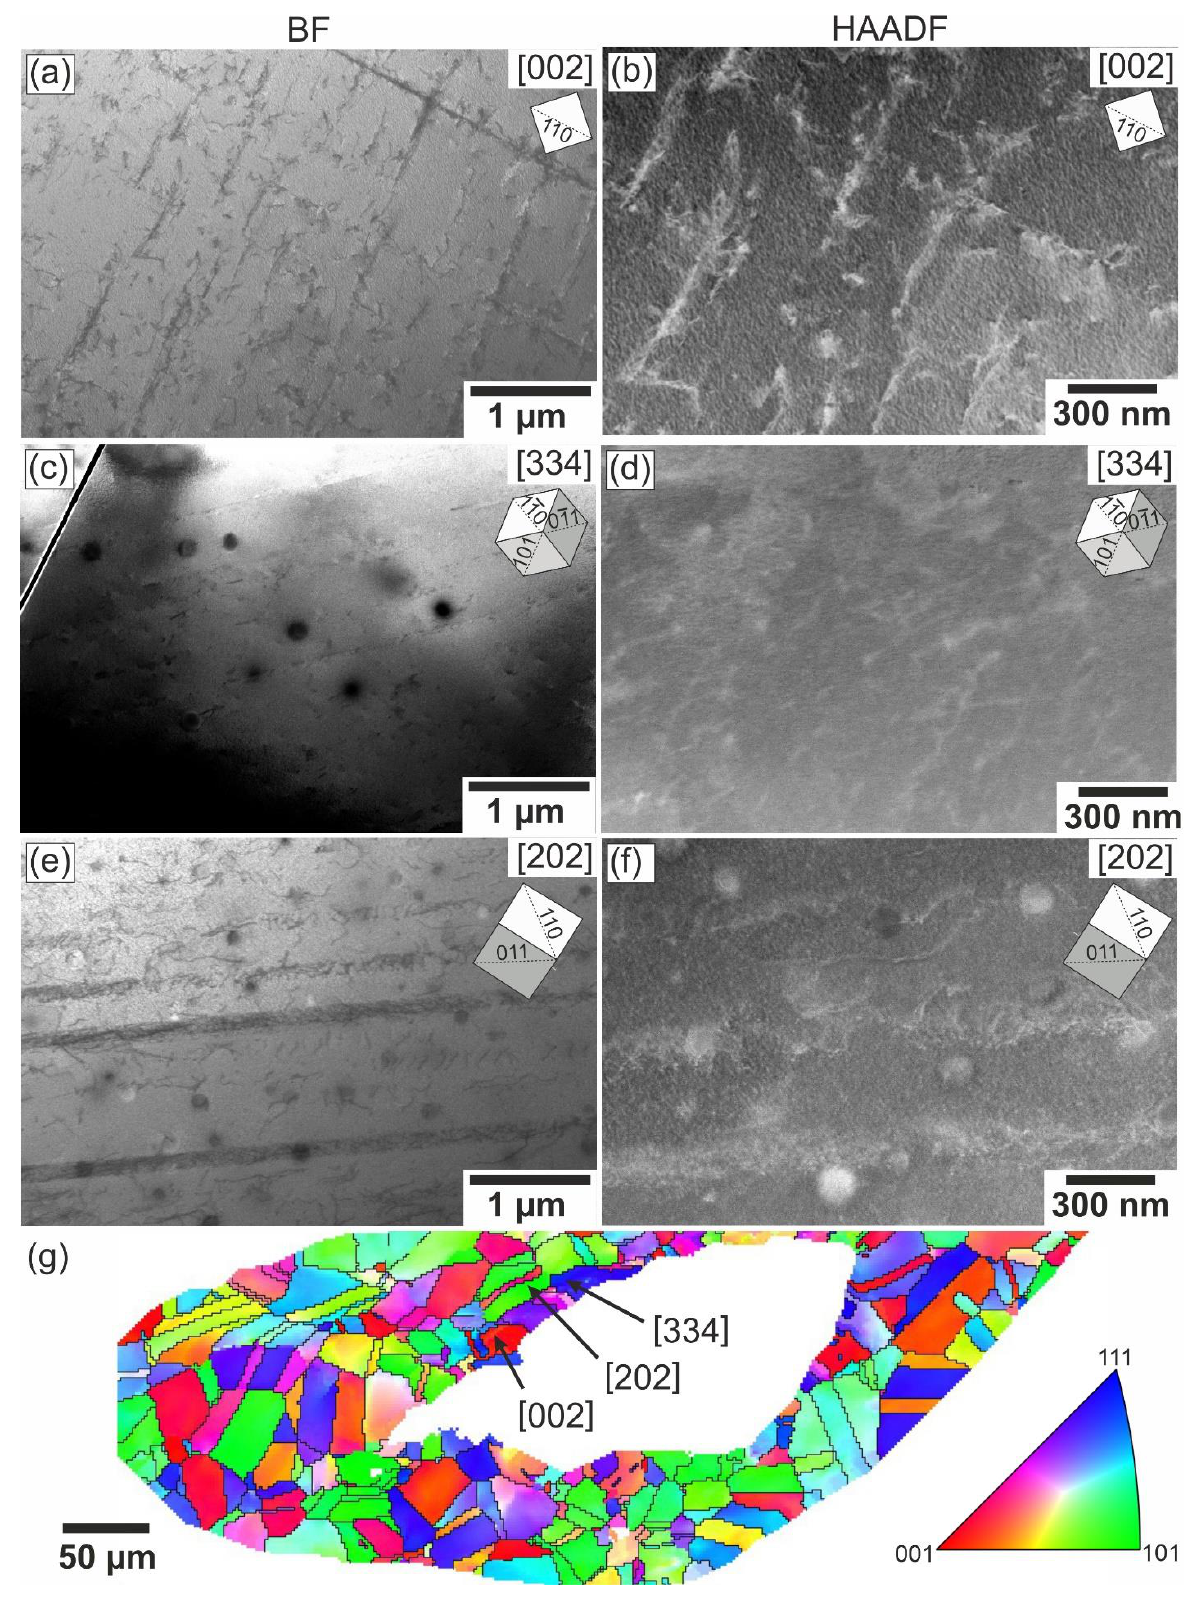
Figure 9. ( a , c , e ) BF and ( b , d , f ) HAADF STEM images of three grains with different orientations in the sample deformed at room temperature. The viewing direction is parallel to the loading direction. The cube in the upper right corner illustrates the crystallographic orientation of the grain. The orientation was determined by EBSD ( g ).